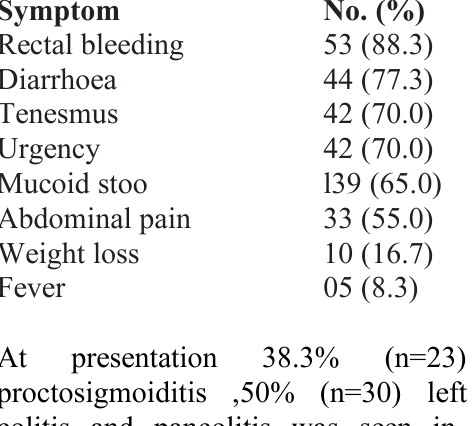
53.3% patients had mild disease, 38.3% and disease. 3.33% (n=2) had to undergo surgical